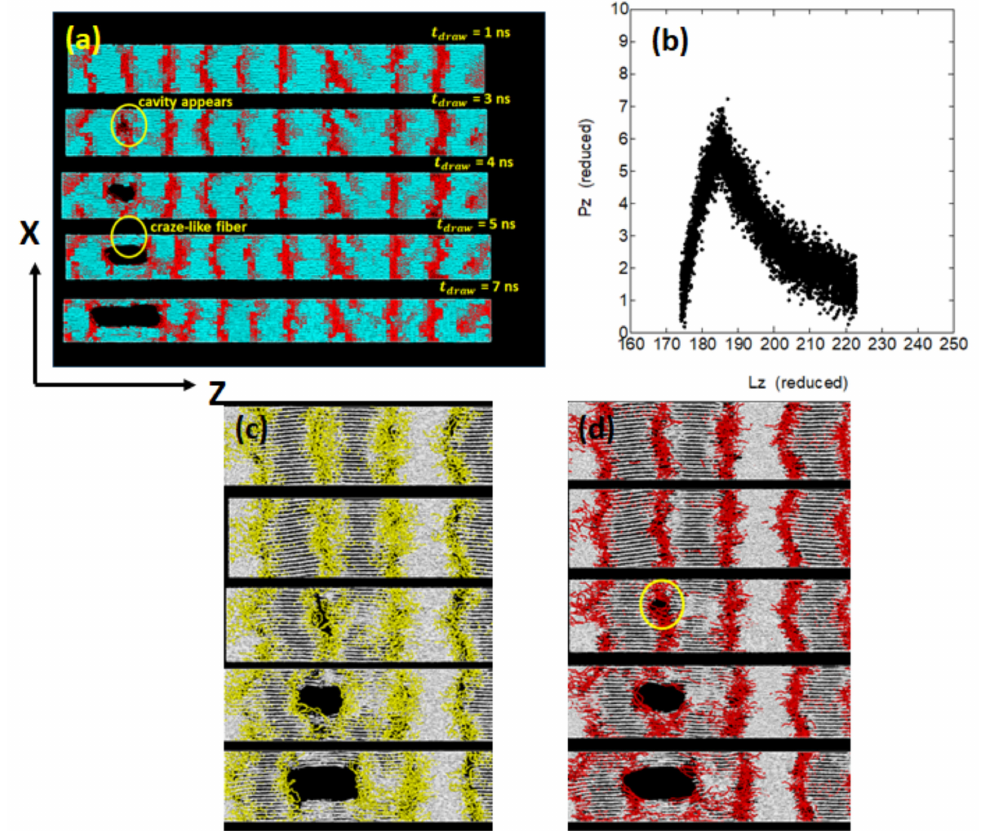
Figure 9. Uniaxial deformation along the Z -axis, with the true rate 0.05/ns, for the type-P (Figure 8c) in the well-developed stacked lamellae system of 150,000 united atoms, ( a ) snapshots during the deformation at 1~7 ns, where the blue and red regions correspond to the crystalline and amorphous regions, respectively, ( b ) the stress–strain curve, and the conformational changes in ( c ) the fold segments and ( d ) the ties segments, where white, yellow, and red segments correspond to the crystalline, fold, and tie chains,